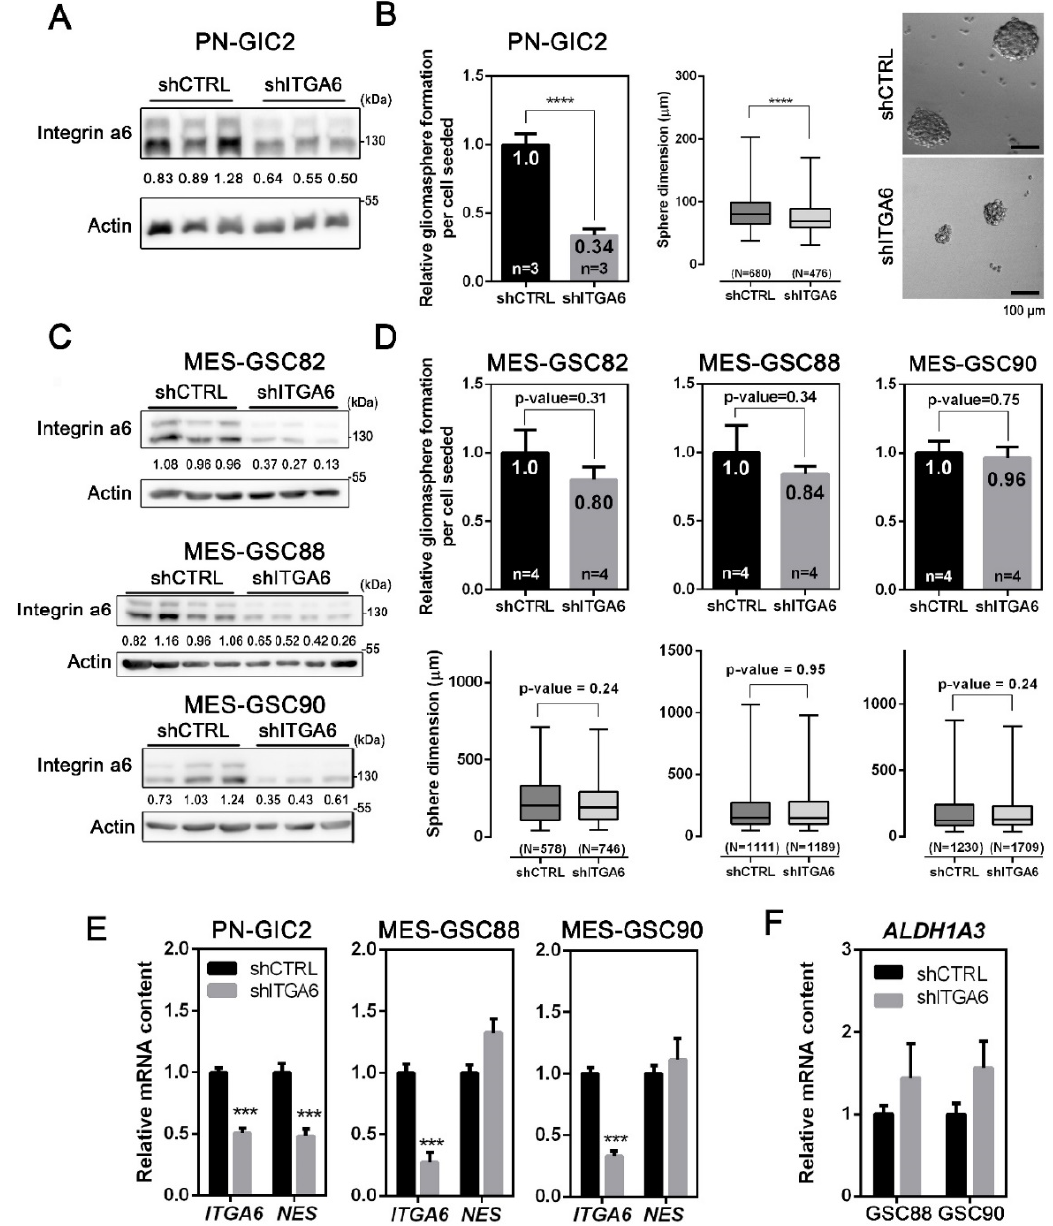
Figure 2. Silencing of integrin a6 in MES-GSCs does not have an impact on stemness and self-renewal. ( A , C ) Representative Western blot of the lentiviral-based shRNA silencing of ITGA6 in PN-GIC2 ( A ) and MES-GSCs ( C ). The values indicated within blots are relative to the densitometric analysis. Numbers indicate the normalized integrin a6 intensity ratio relative to the mean of normalized shCTRL samples. ( B ) Assessment of self-renewal capacity (mean ± SEM; n = 3; unpaired t -test) and sphere size (mean ± SEM; n = 3; Mann–Whitney test) in PN-GSCs silenced for ITGA6 . Micrographs from representative fields of gliomaspheres (scale bar = 100 µ m). ( D ) Self-renewal capacity (mean ± SEM; n = 4; unpaired t -test) and sphere size (mean ± SEM; n = 4; Mann–Whitney test) in MES-GSCs silenced for ITGA6 . The number of independent experiments— n , the number of gliomaspheres scored for each condition—N. The values specified within the bar plot indicate the mean relative self-renewal capacity. ( E ) Transcript levels of ITGA6 and NES detected by means of qPCR in shITGA6 PN-GSCs and MES-GSCs (mean ± SEM; n = 3; unpaired t -test). ( F ) Relative transcript amount of ALDH1A3 , a specific MES stem cell marker, in shITGA6 MES-GSCs (mean ± SEM; n = 3; unpaired t -test). *** p < 0.001; **** p < 0.0001